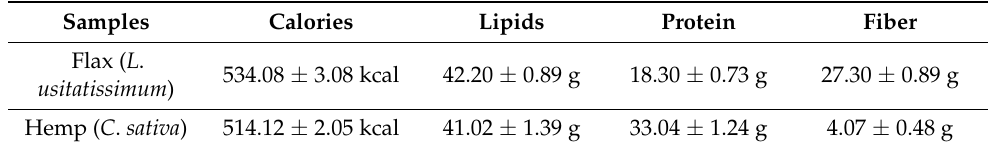
Table 1. Nutritional parameters of the investigated seeds (100 g/sample).